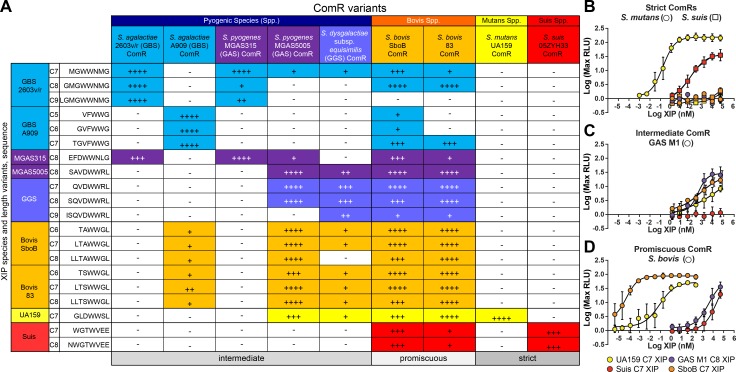
Type-II ComRs expressed in the ES1 (ΔcomRS) test-bed strain exposed to heterologous XIPs can be grouped into strict, intermediate or promiscuous ComRs based upon relative activity profiles.(A) Type-II ComR proteins were tested for the ability to promote luciferase expression using putative XIP proteins of varying length from both the same and heterologous species. The normalized test-bed activities for each ComR variant is defined as 100% for luminescence activity stimulated by the cognate XIP; activities from heterologous pairings are calculated by dividing the activity from the cognate XIP by the maximum luminescence attained from the heterologous XIP and represented as (++++) for >90%, (+++) for 70–89%, (++) for 50–69%, and (+) 25–49%, no observable induction is denoted by (-). Color indicates species. (B-D) Five representative strains that exhibit different ComR activity profiles: strict, intermediate, and promiscuous. (B) Strict ComRs, S. mutans UA159 (circles) and the S. suis 05ZYH33 (squares), exclusively respond to cognate XIPs, UA159 C7 XIP (yellow) and suis C7 (red), respectively. (C) The intermediate ComR of S. pyogenes MGAS5005 (circles) exhibits reporter activity when treated with the cognate GAS M1 C8 XIP (purple), UA159 C7 XIP (yellow), and the S. bovis SboB C7 XIP (orange) with different EC50 values. No activity is observed when treated with the suis C7 XIP (red). (D) The promiscuous ComR of S. bovis SboB (circles) exhibits strong activity upon treatment with the cognate SboB C7 XIP (orange) with an apparent EC50 of <1 nM. The SboB ComR also exhibits dose-responsive reporter activity upon treatment with the UA159 C7 XIP (yellow), the GAS M1 C8 XIP (purple) and Suis C7 XIP (red), which does not contain the WW-motif.